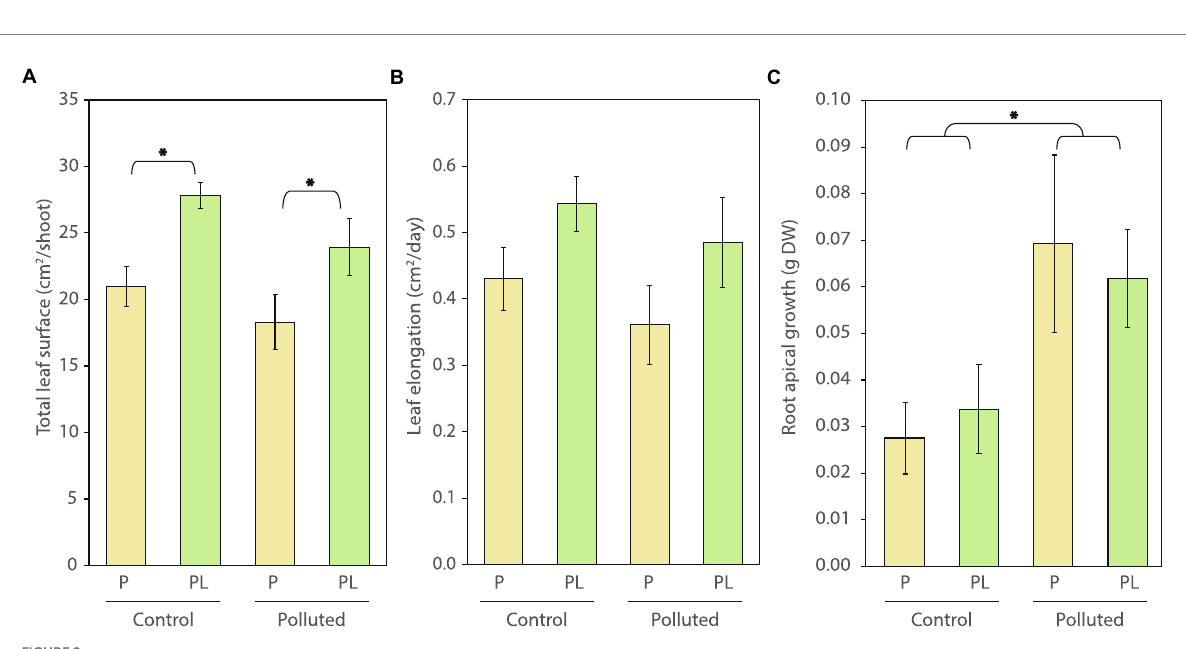
FIGURE 2 Plant morphology and growth. (A) Total leaf surface, (B) leaf elongation, (C) root apical growth of C. nodosa at the end of the experiment (±SE, n = 3). Levels of the factor “Community” are identified with letters as indicated in the methods. Colors indicate absence (yellow) or presence (green) of the interaction with lucinid clams. Asterisks (* p < 0.05) indicate significant differences; see Supplementary Tables S5, S6 for the statistics.